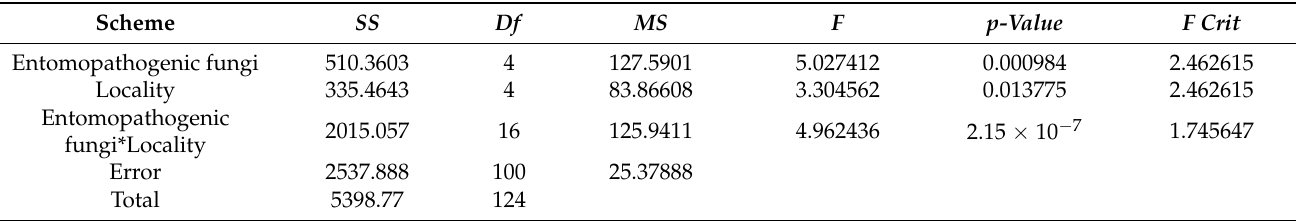
Table 3. Comparison of the number of colony-forming units (CFU g − 1 ) in soil, by entomopathogenic fungi and localities using a two-way analysis of variance (ANOVA).